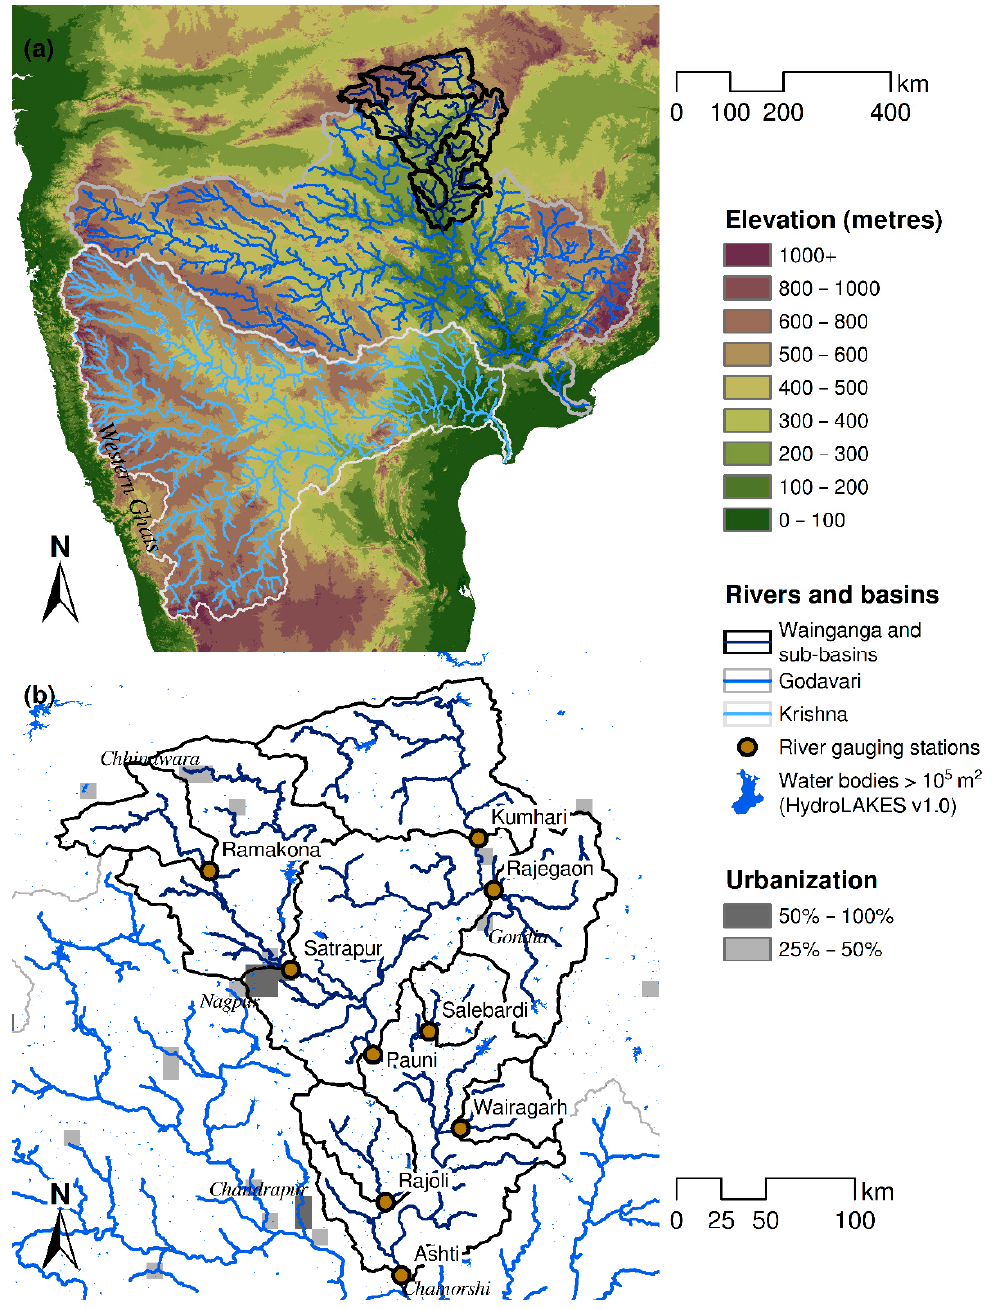
Figure 1. ( a ) Map of the Wainganga, Godavari and Krishna basins within central/south mainland India; ( b ) Close-up of the Wainganga catchment and sub-catchments with named river gauging stations and cities.